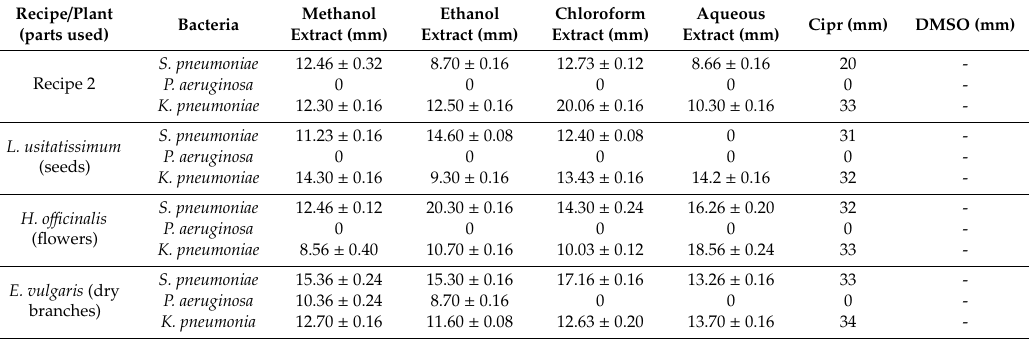
Table 4. Antibacterial activity of Recipe 2 and its individual plant extracts against three bacterial